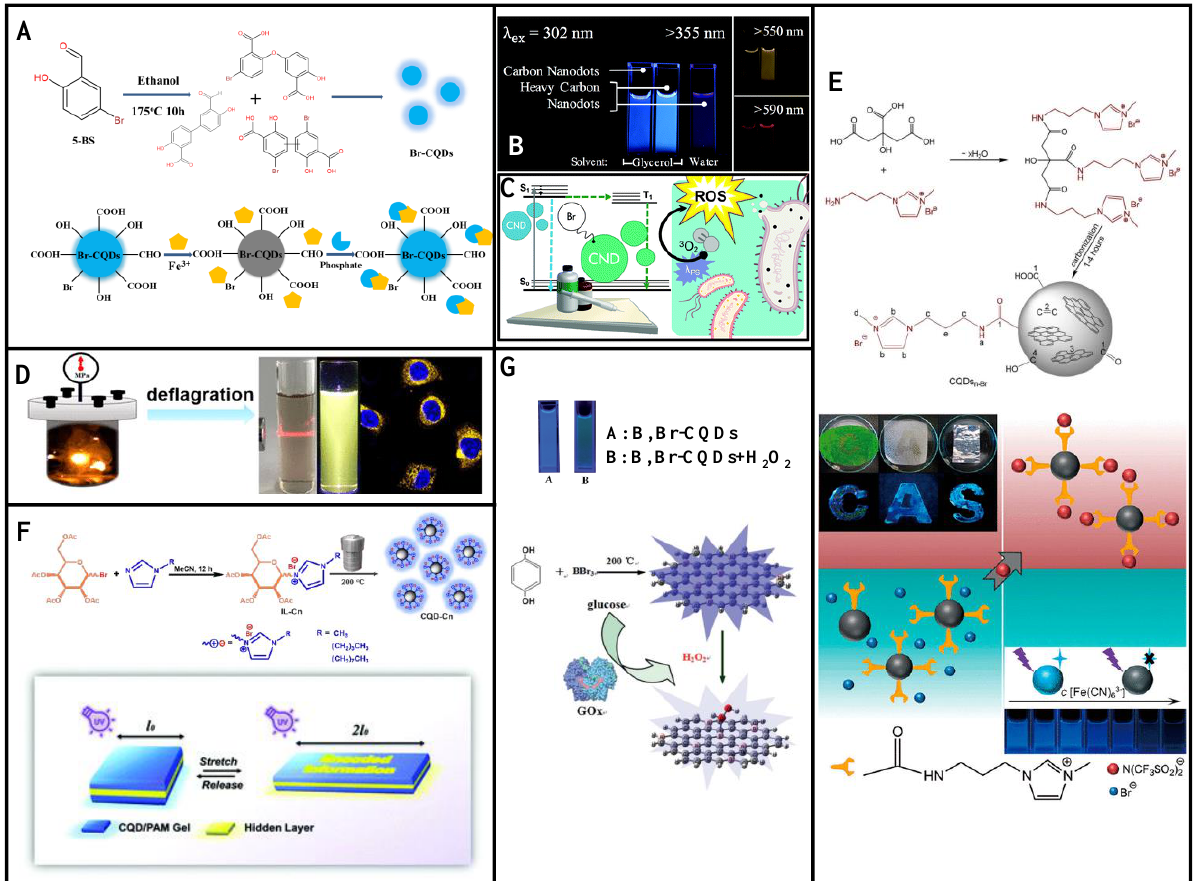
Figure 7. Synthesis and applications of Br-doped CDs. ( A ) Br-CQDs were synthesized with 5-BS as the precursor, and its fluorescence was quenched with Fe ions. Phosphate can be added to restore fluorescence. ( B ) By doping bromine atoms, CDs exhibit room-temperature phosphorescence via the heavy-atom effect. ( C ) Br-doped CDs exhibit Type I and Type II photosensitization under UVA irradiation via the heavy-atom effect and possess excellent antibacterial properties. ( D ) NBr-CQDs were synthesized using the deflagration method for cell imaging. ( E ) Synthesis and application of ionic liquid-modified CQDs. ( F ) Schematic of the imidazole ionic liquid NBr-doped CQDs syn- thesis and its use in information encryption. ( G ) Schematic of the BBr-CQD synthesis, which can be quenched by hydrogen peroxide. The quenching reaction can be used to detect Gox activity. Reprinted/adapted with permission from Refs. [86,87,90,91]. Copyright 2014, 2018, 2020, and